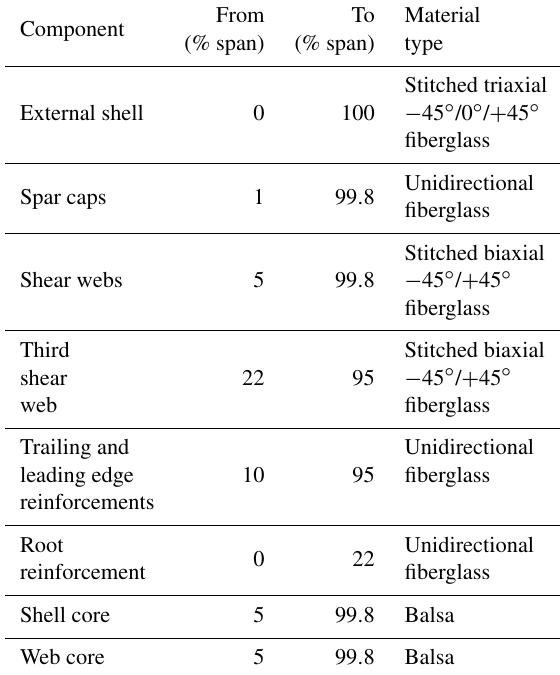
Table 9. Summary of the material properties used in the blades of the 10MW wind